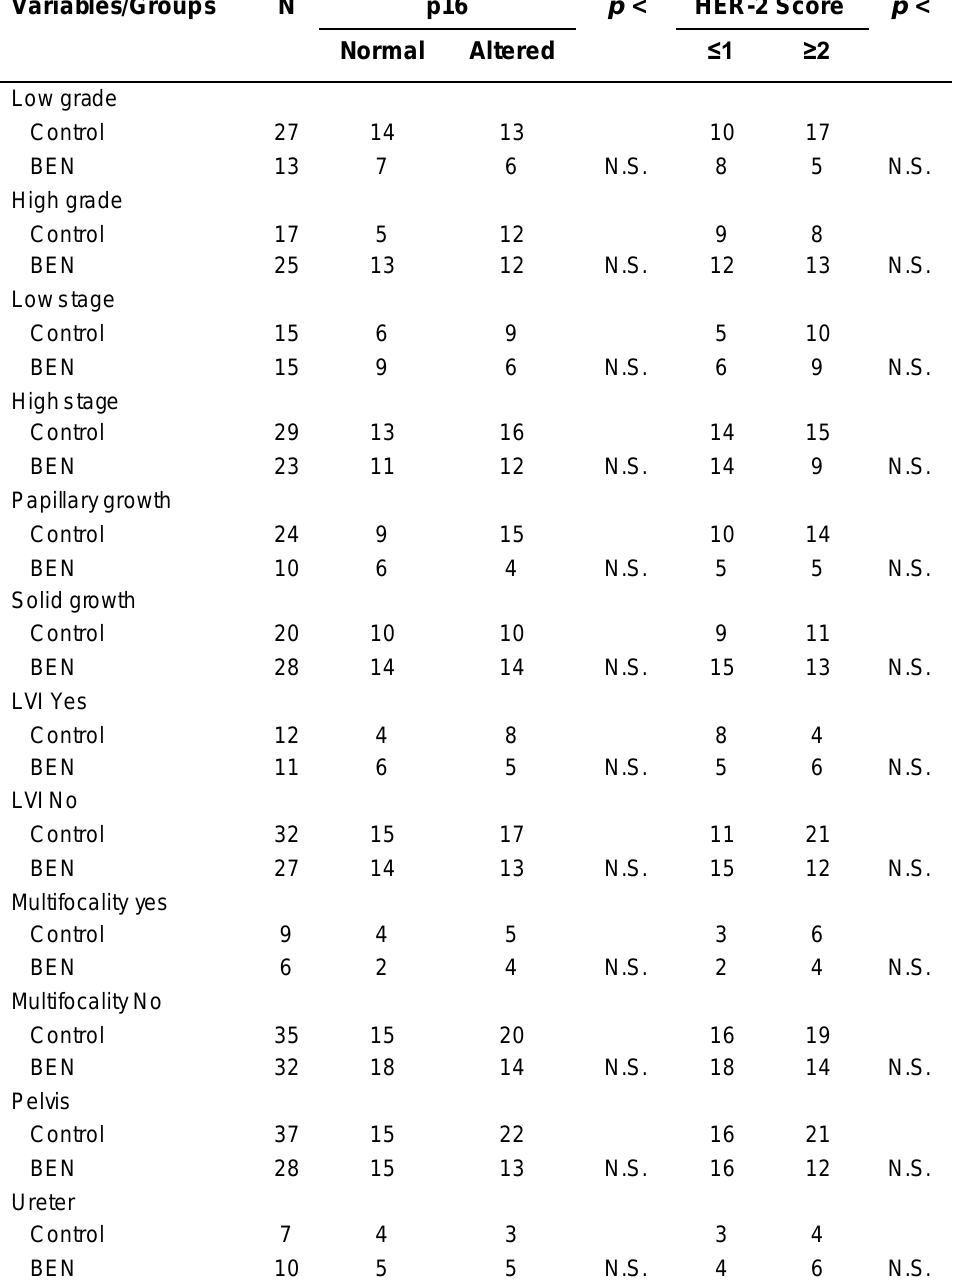
Pathological Variables of UUC and Expression of p16 and HER-2 in Control and BEN Tumors